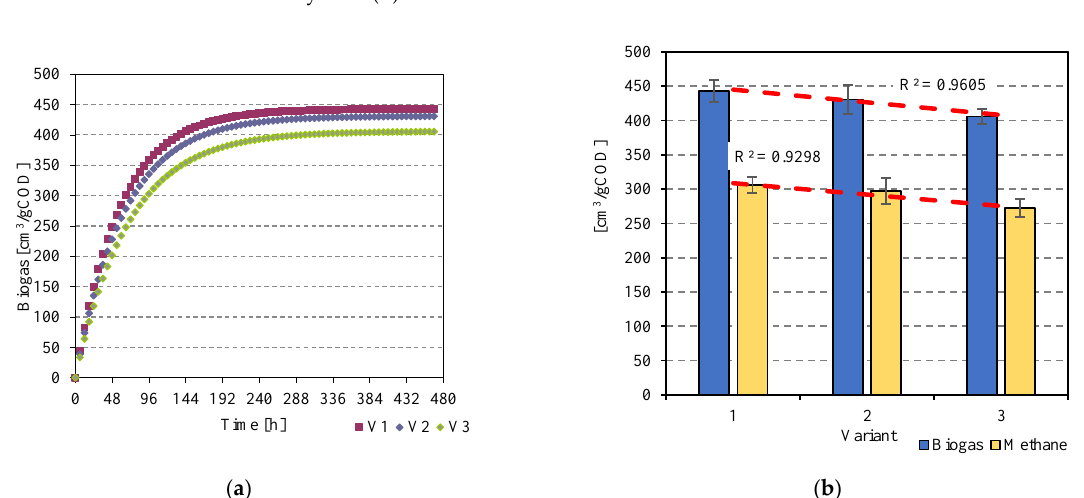
Figure 3. The course of AD process ( a ) and correlations between OLRs applied and biogas and methane yields ( b ) achieved in S1.